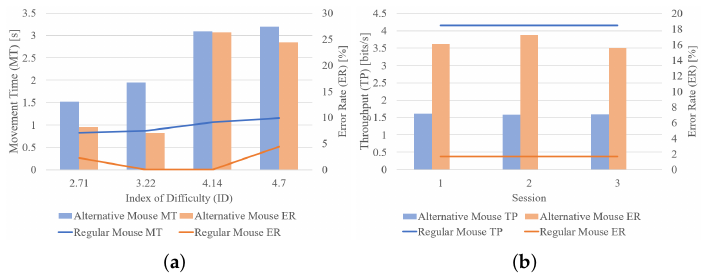
Figure 13. Graphs to compare the performance of the alternative mouse to the regular one. ( a ) MT and ER plotted over ID for the alternative and regular mice. ( b ) TP and ER plotted over sessions for both mouse input